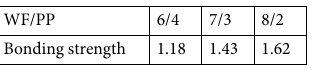
Table 2. Surface bonding strength